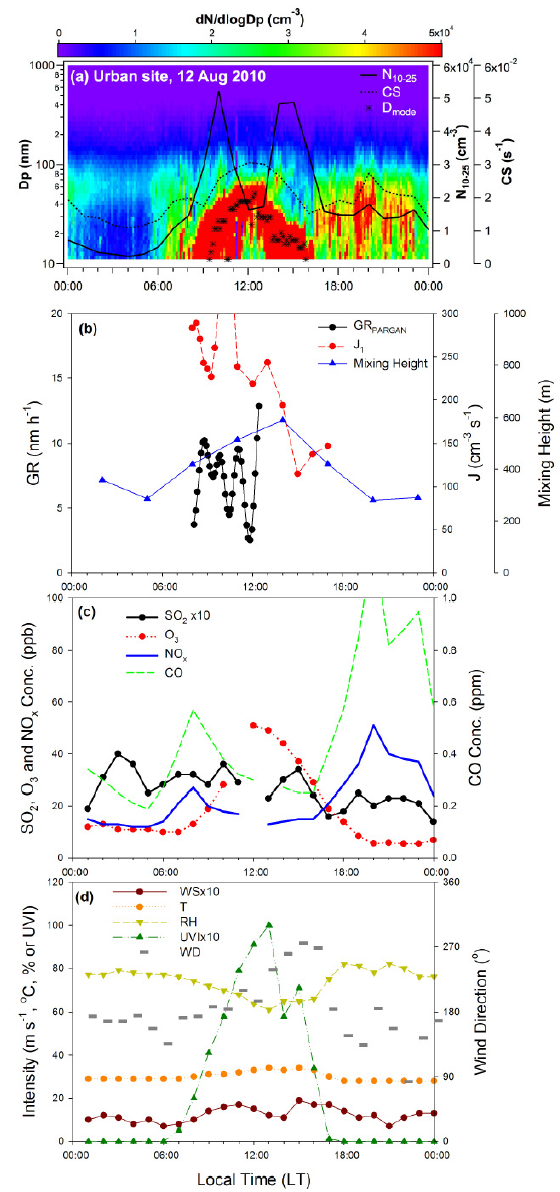
Fig. 6. The same as Fig. 3, except this is for a NPF, growth and shrinkage event on the 3 January